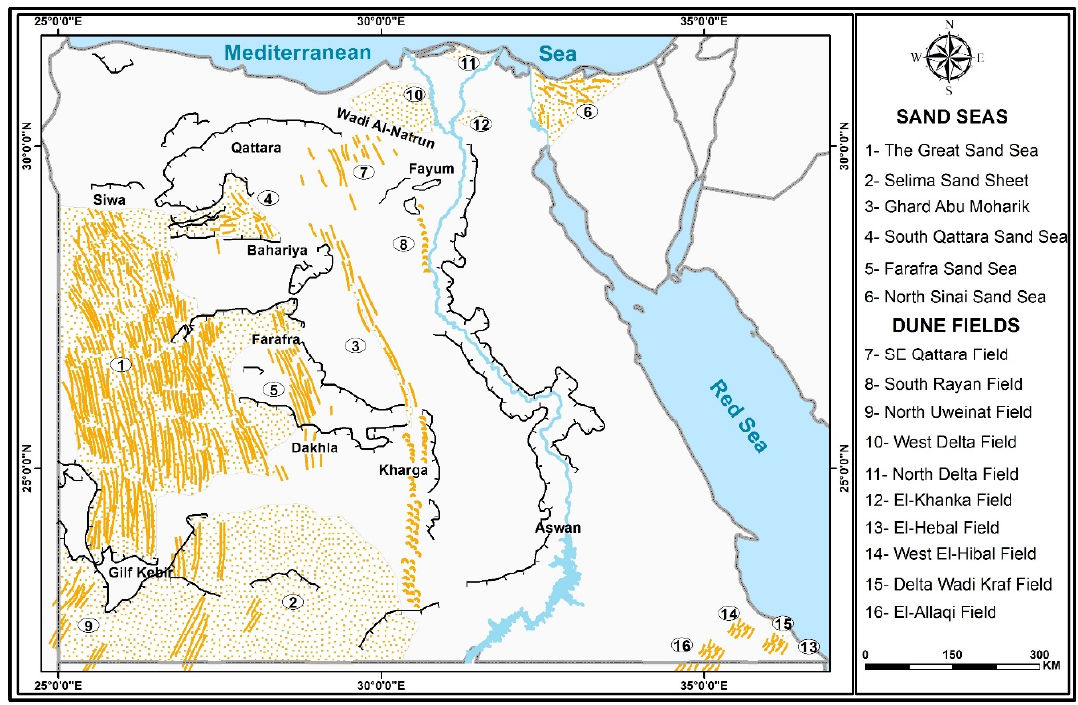
Figure 2. Distribution of sand seas and dune fields in Egypt.